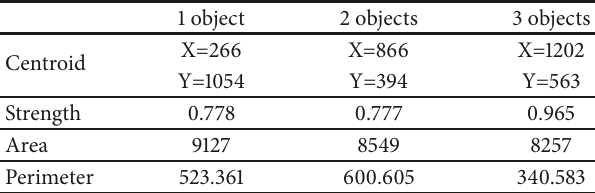
Table 1: Values obtained with the morphological